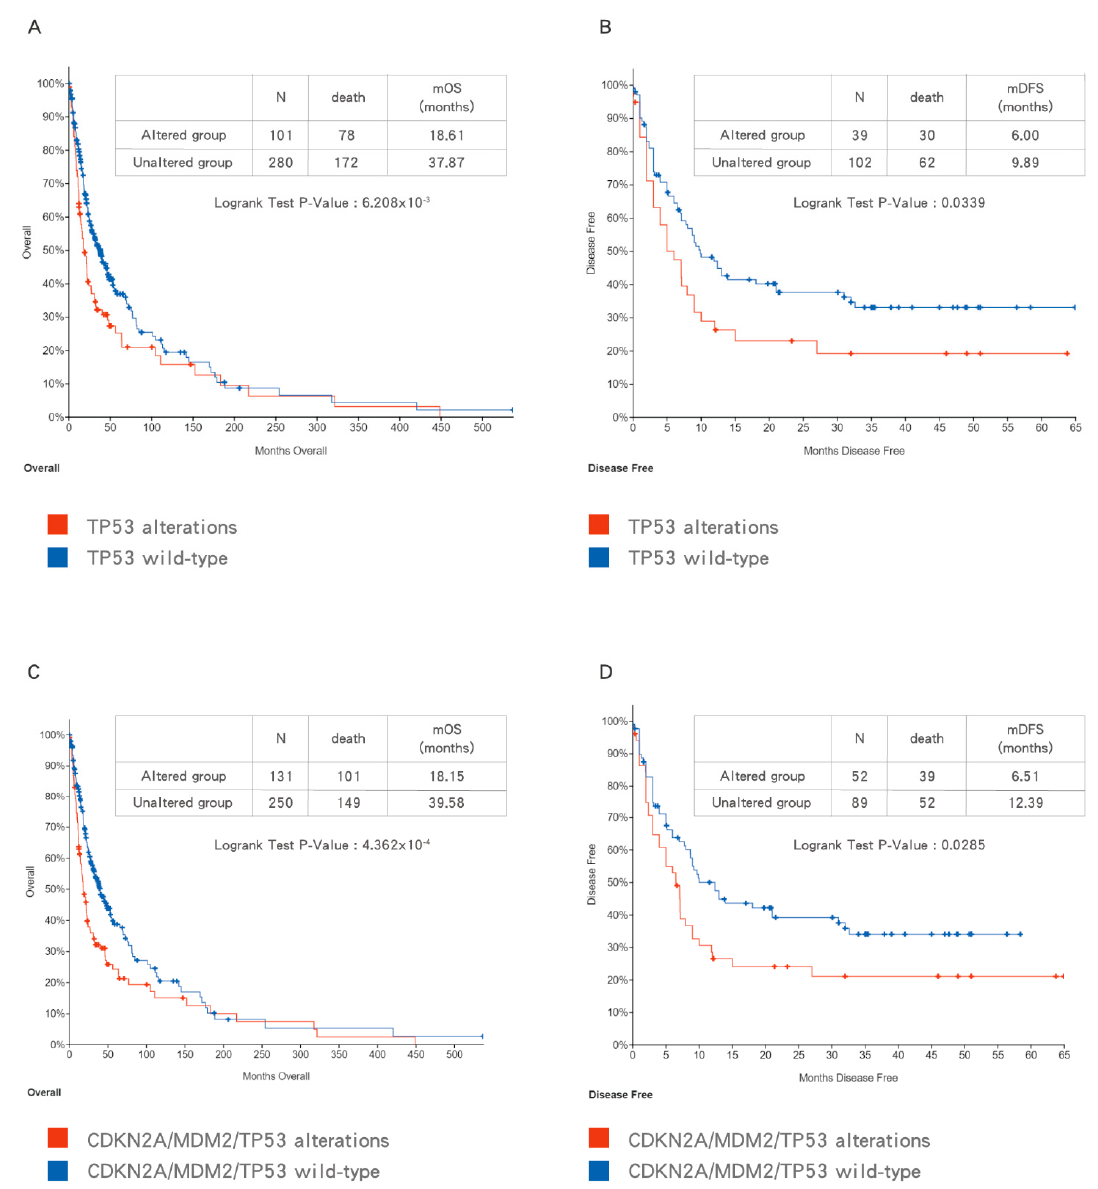
Figure 4. The impact of TP53 mutation ( A , B ) and CDKN2A / MDM2 / TP53 alterations ( C , D ) on overall survival (OS) ( A , C ) and disease-free survival (DFS) ( B , D ) in biliary tract cancers (BTCs). Data were accessed at cBioPortal on 3 September 2020.